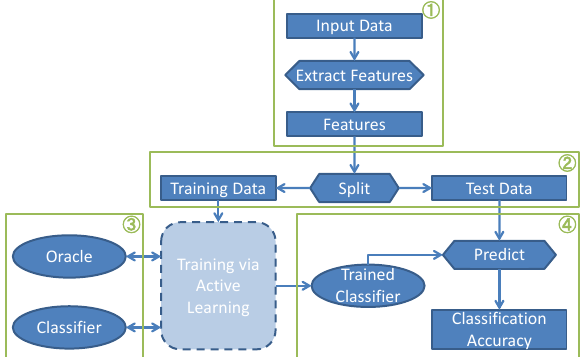
Figure 1. Outer view of the concept for active learning evaluation. The four components are detailed in their respective sections. On this level of abstraction active learning is viewed as a black